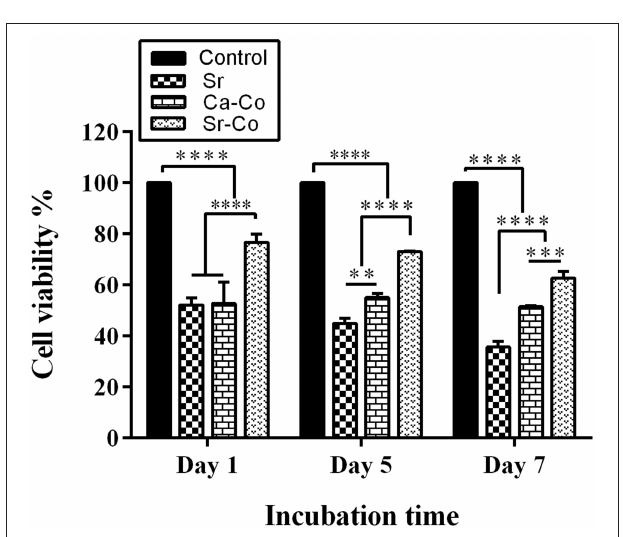
FIGURE 3 | The graph representing the viability percentage of the iPSCs cultured in the 2D system (control group) and onto different glass samples after at days 1, 5, and 7. * p < 0.05, ** p < 0.01, *** p < 0.001, and **** p <